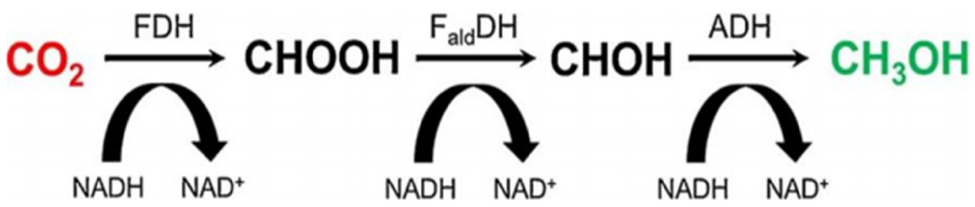
Figure 1. The biocatalytic pathway of the enzymatic conversion of CO 2 to CH 3 OH reported by Obert and Dave [12].